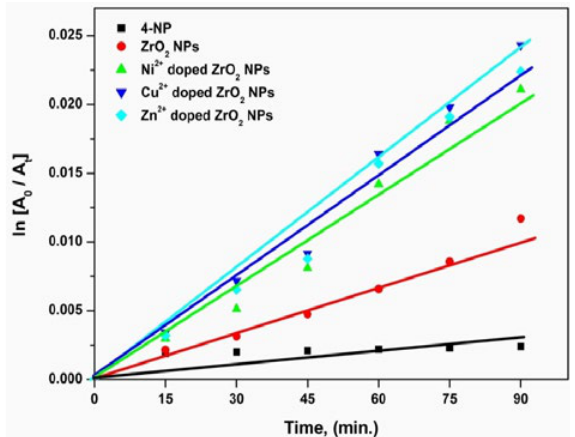
Fig. 8 Linear plots of ln(A 0 /A t ) vs. time for the catalytic reduction of 4-nitrophenol over the synthesized undoped and doped ZrO 2 NPs.